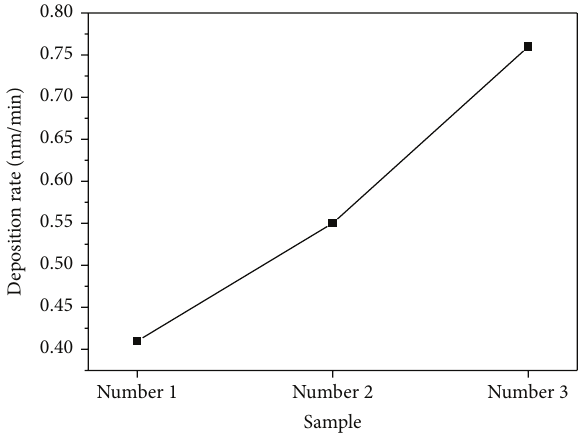
Figure 2: The TiO 2 deposition rate for samples number 1, number 2, and number 3 (without nitrogen addition).